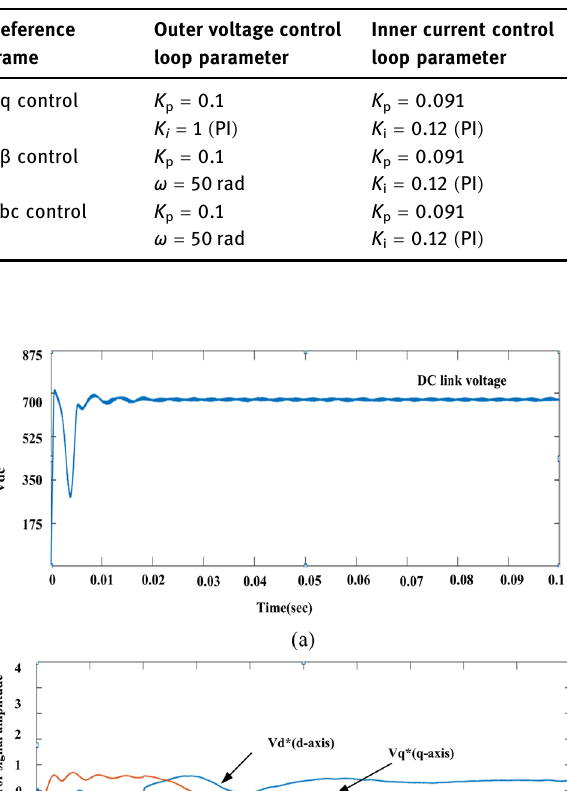
Table 2: Speci fi cation of the controller parameters